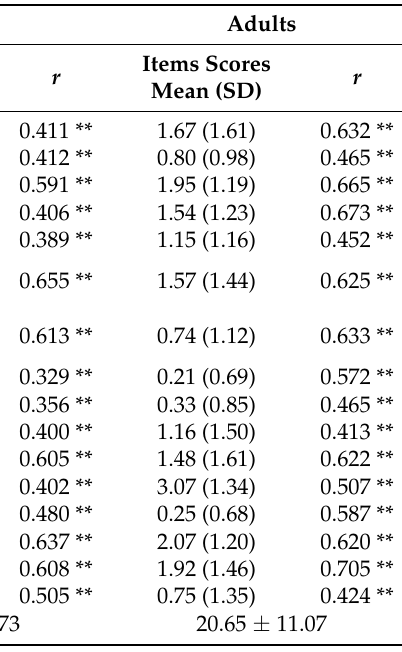
Youths Adults Items Scores Items Scores r Mean (SD) Mean (SD)